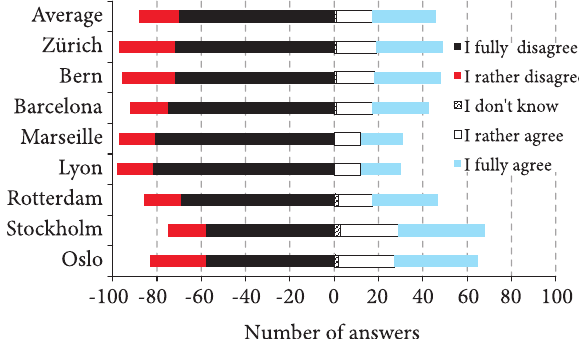
fig. 2. View on road pricing to reduce traffic congestion and nuisances in the